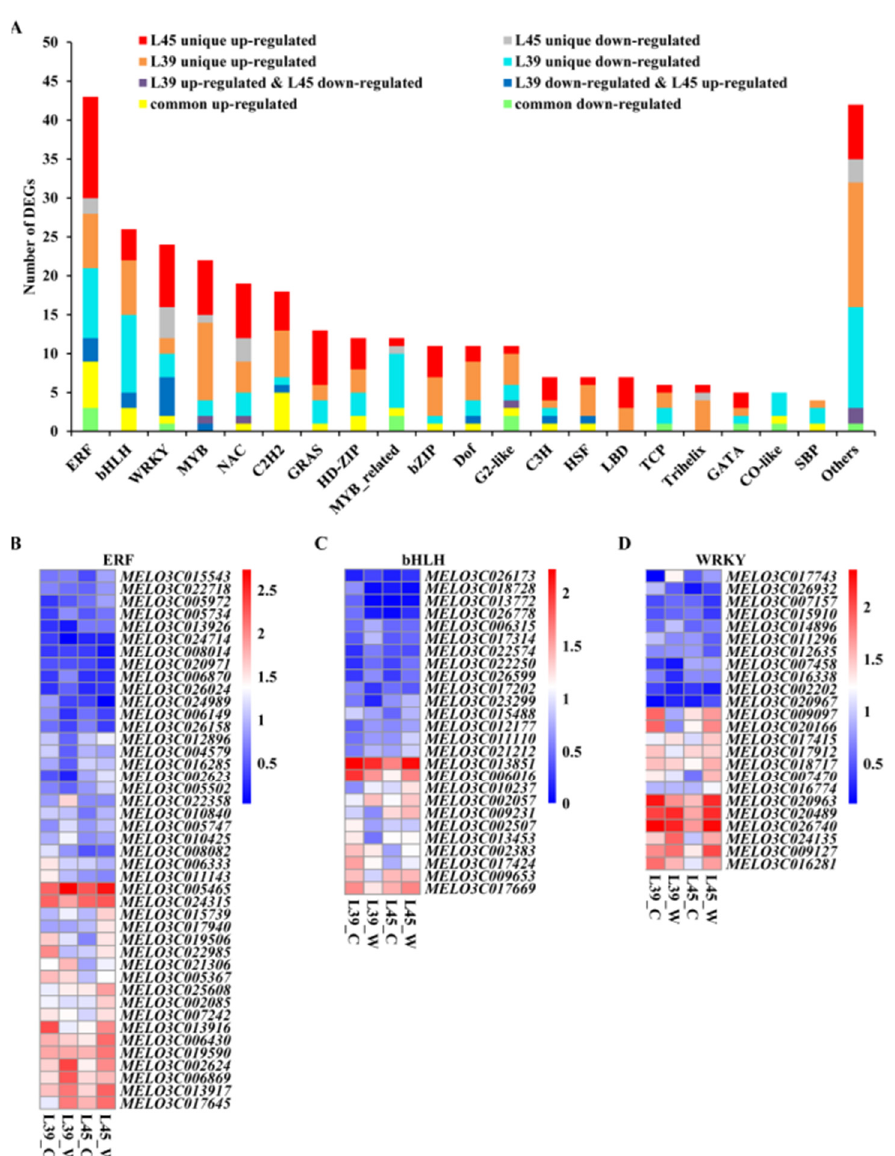
Figure 9. Analysis of differentially expressed transcription factors. ( A ) Graphical representations of waterlogging-responsive transcription factors, based on the assigned gene families. ( B – D ) A heatmap analysis of ERF, bHLH and WRKY families in ‘L39’ and ‘L45’, under control and waterlogging stress conditions. The levels of gene expression are shown by log 10 (FPKM+1).